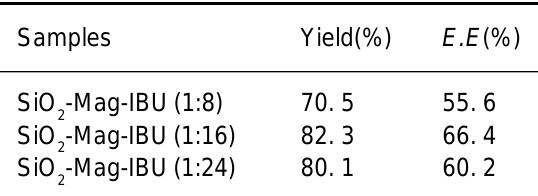
Table 2. Yield and encapsulation efficiency ( E.E ) values.